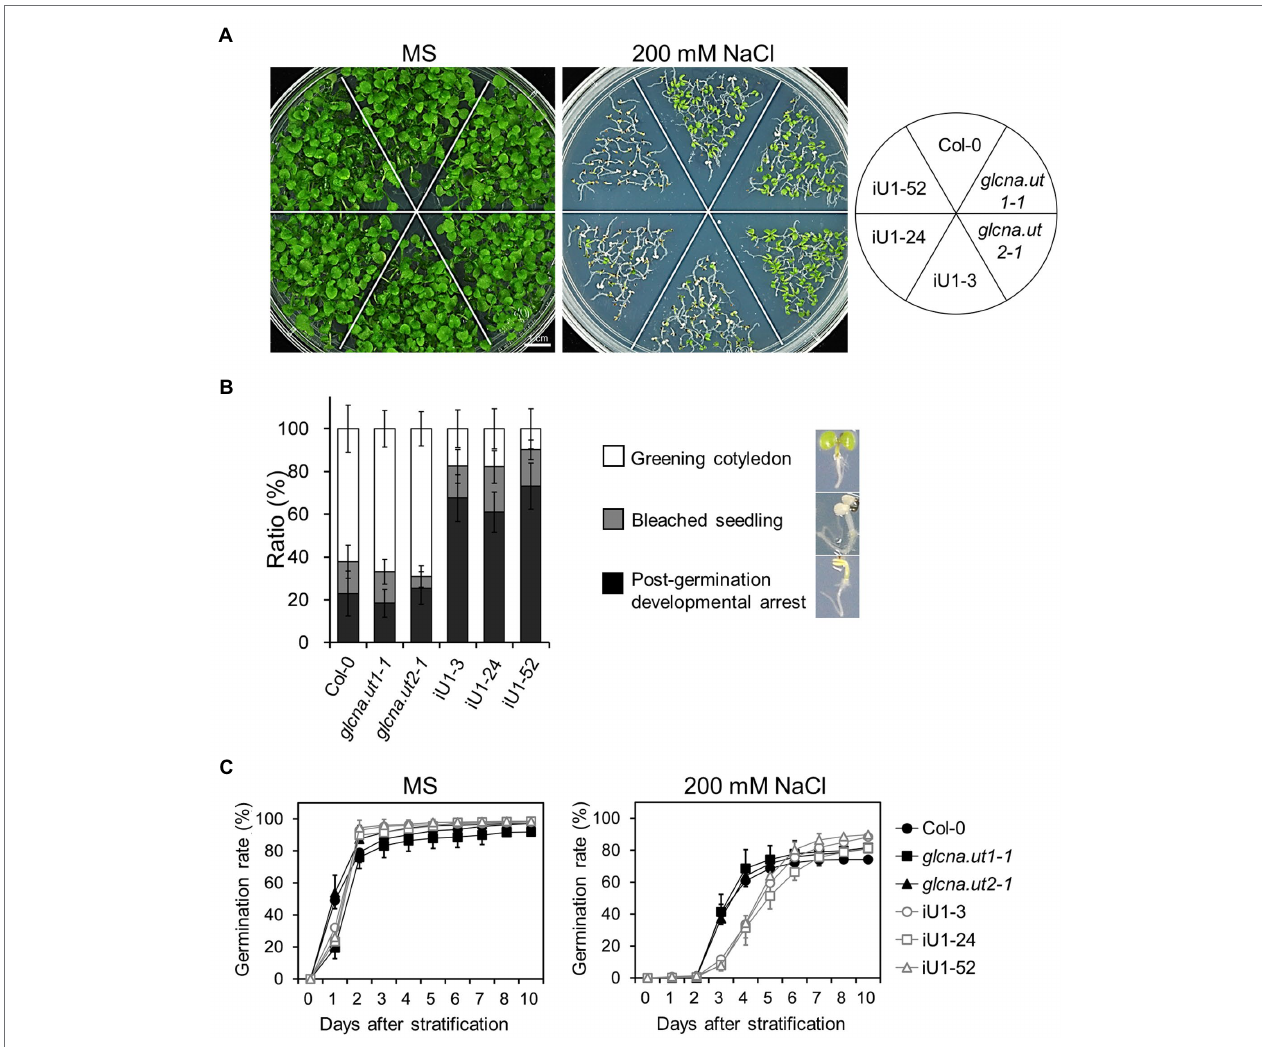
FIGURE 2 | Salt hypersensitivity of the iU1 transgenic plants. (A) Salt hypersensitivity. Seedlings were grown on MS or 200 mM NaCl-containing media for 14 days. (B) Analyses of the salt-treated seedling phenotypes. Data are presented as the means ± SD of at least eight biological replicates. Each replicate contained ~45 seeds. (C) Seed germination. Data are presented as the means ± SD of at least 12 biological replicates. Each replicate contained ~40